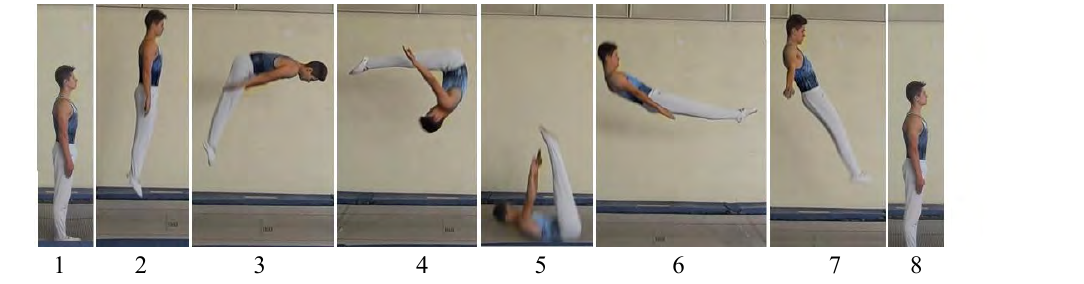
Fig.8. Forward jump with landing on back, bending with arms, directed forward